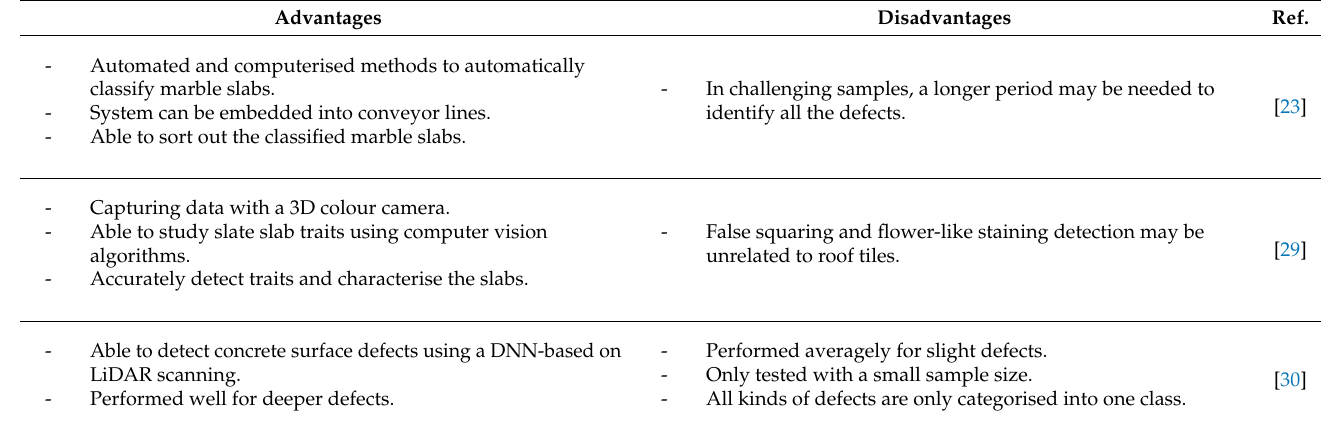
Figure 1. The proposed process of the roof tile manufacturing system. Table 7. Advantages and disadvantages of several inspection